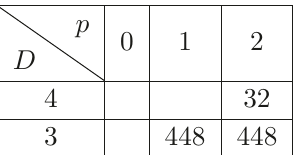
Table 5 . The G 10 , 4 , 1 (IIA) or G 10 , 4 (IIB) family of branes. The branes double and there is an extra multiplicity factor